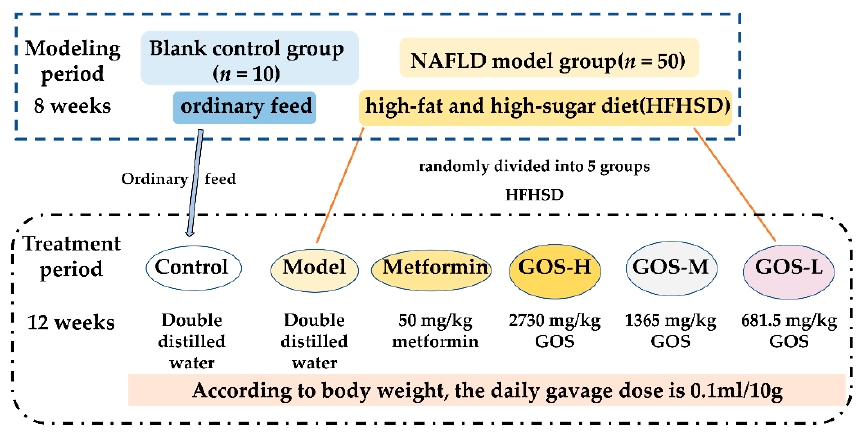
Figure 1. Experimental Design of NAFLD Mice.